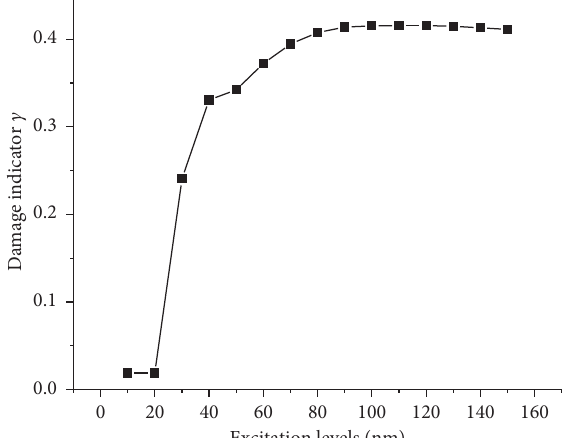
Figure 3: Damage indicator c for various excitation